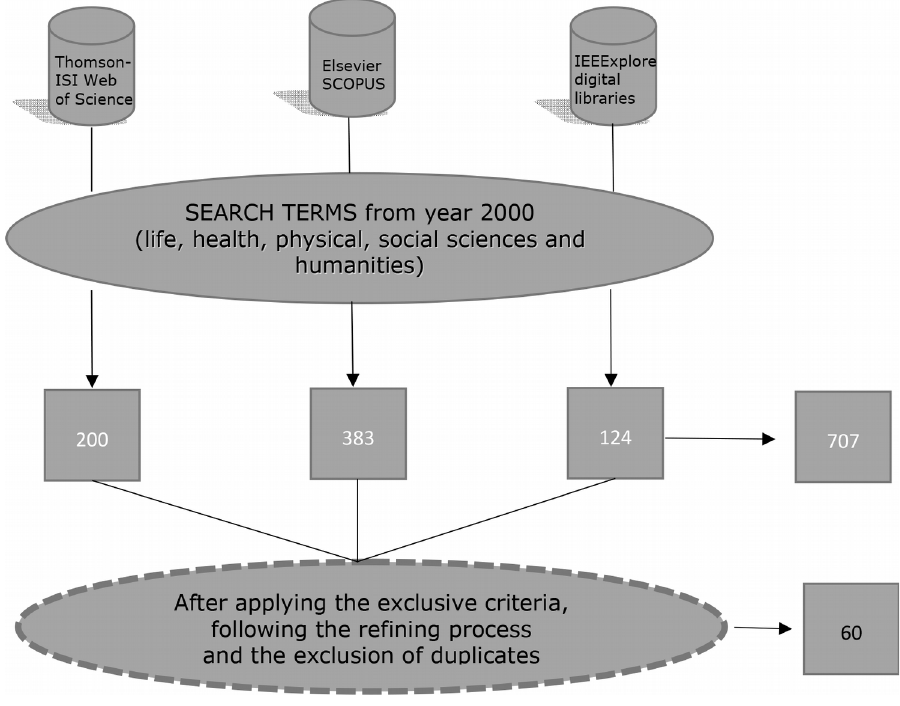
Figure 2. Data collection